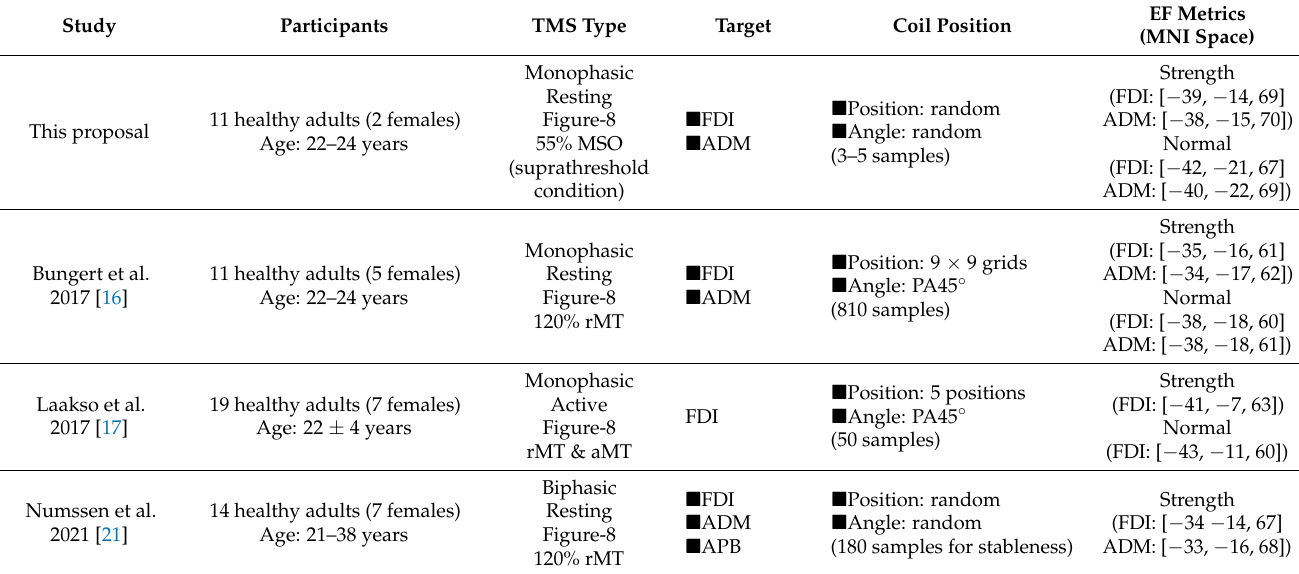
Table 1. Summary of the stimulation conditions used in previous EF-based TMS